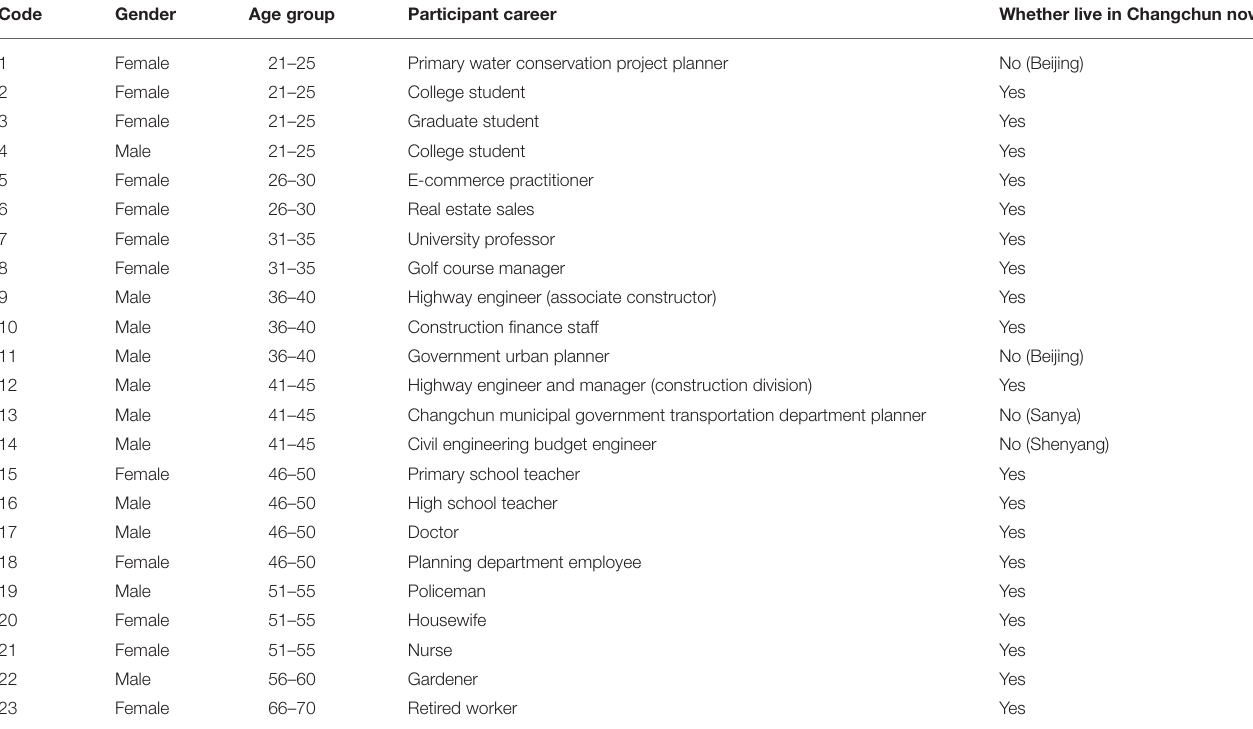
TABLE 1 | Profiles of